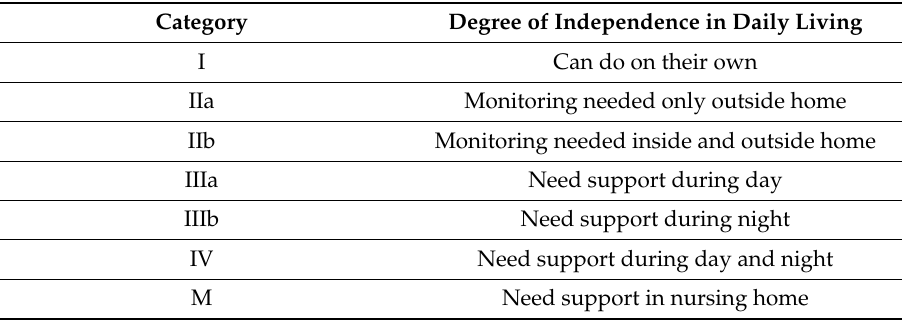
Table 1. Degree of dementia in daily